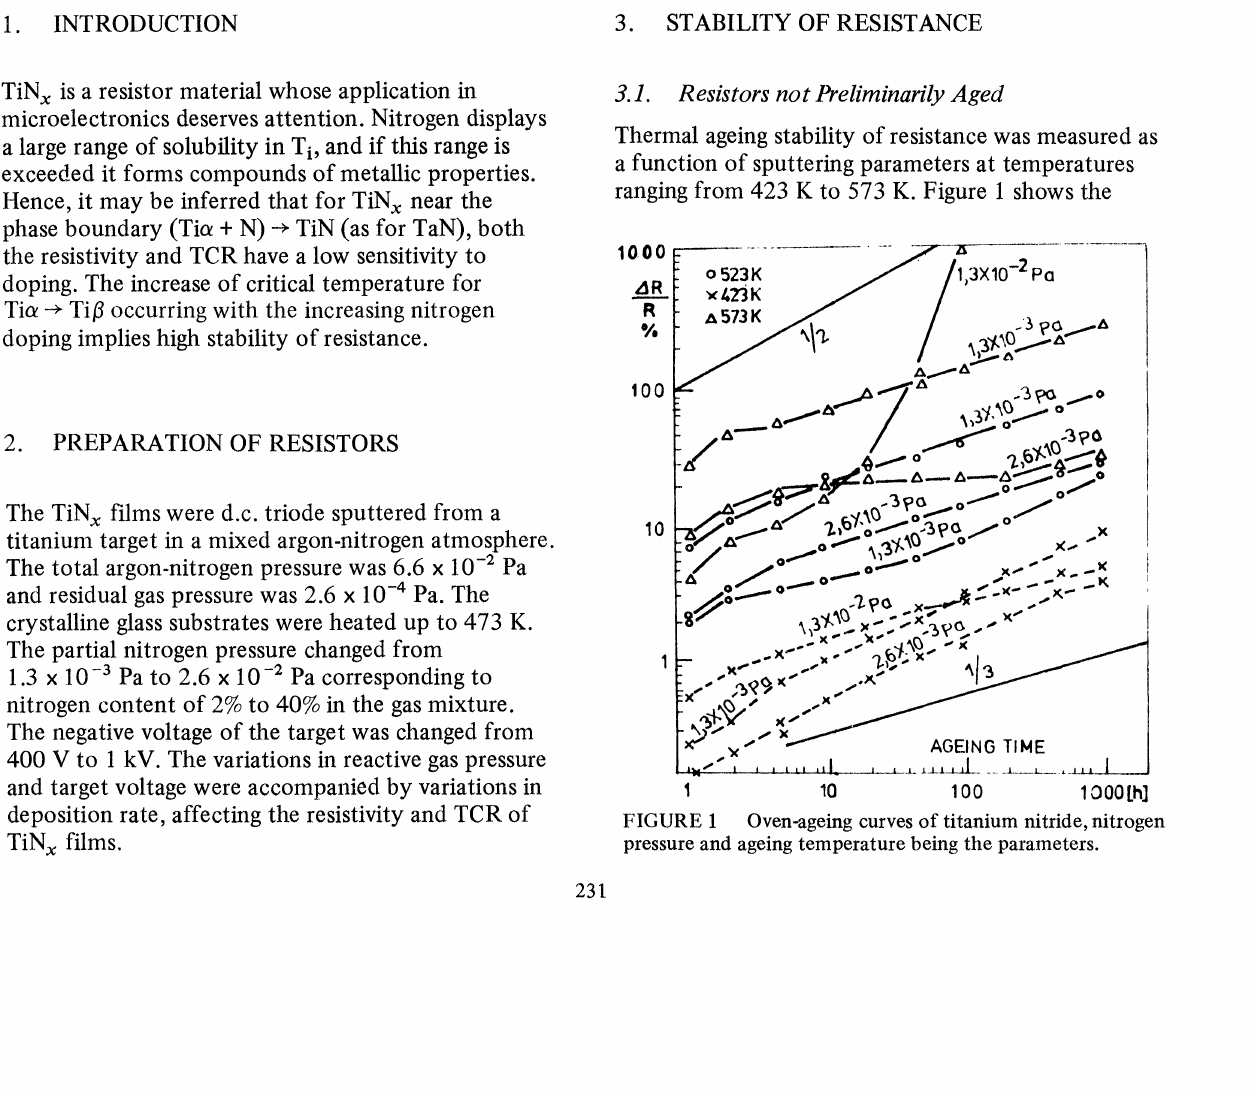
Oven-ageing curves of titanium nitdde, nitrogen pressure and ageing temperature being the